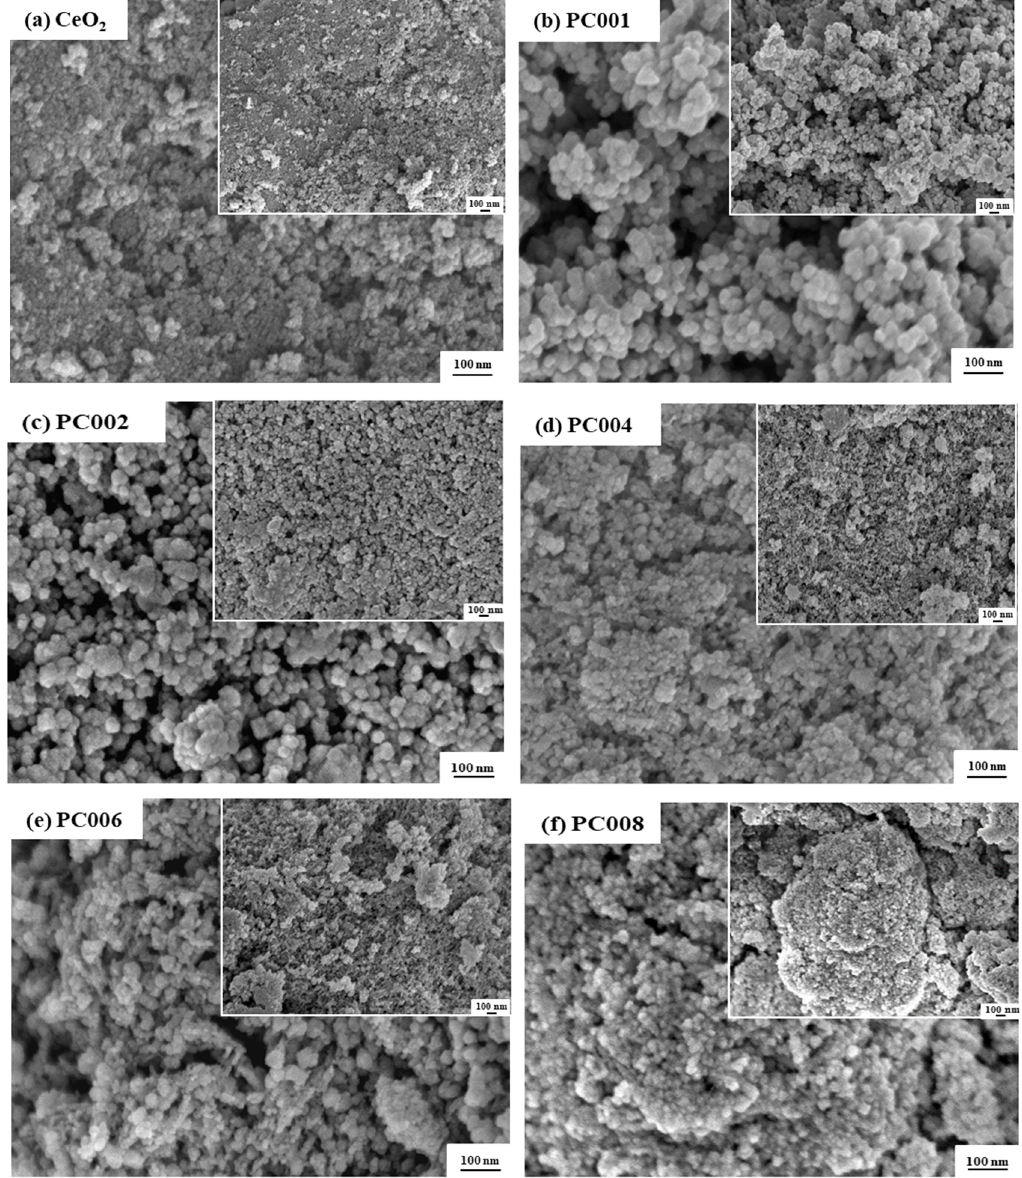
Figure 2. SEM micrographs of the CeO 2 /PANI powders as a function of coated PANI concentration.